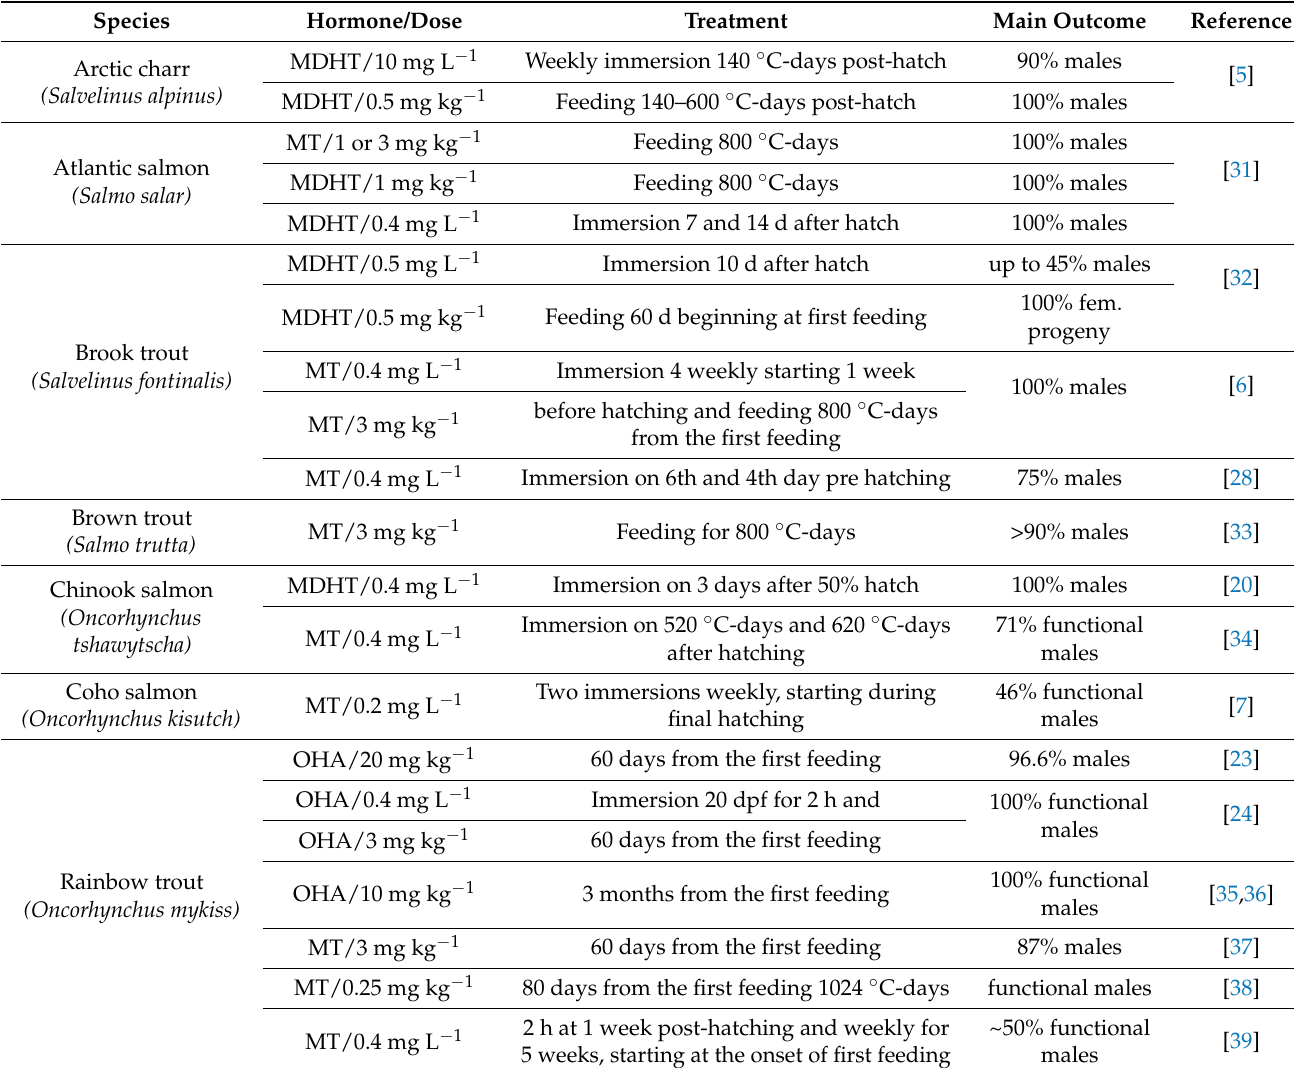
Table 2. Examples of masculinisation protocols in salmonid